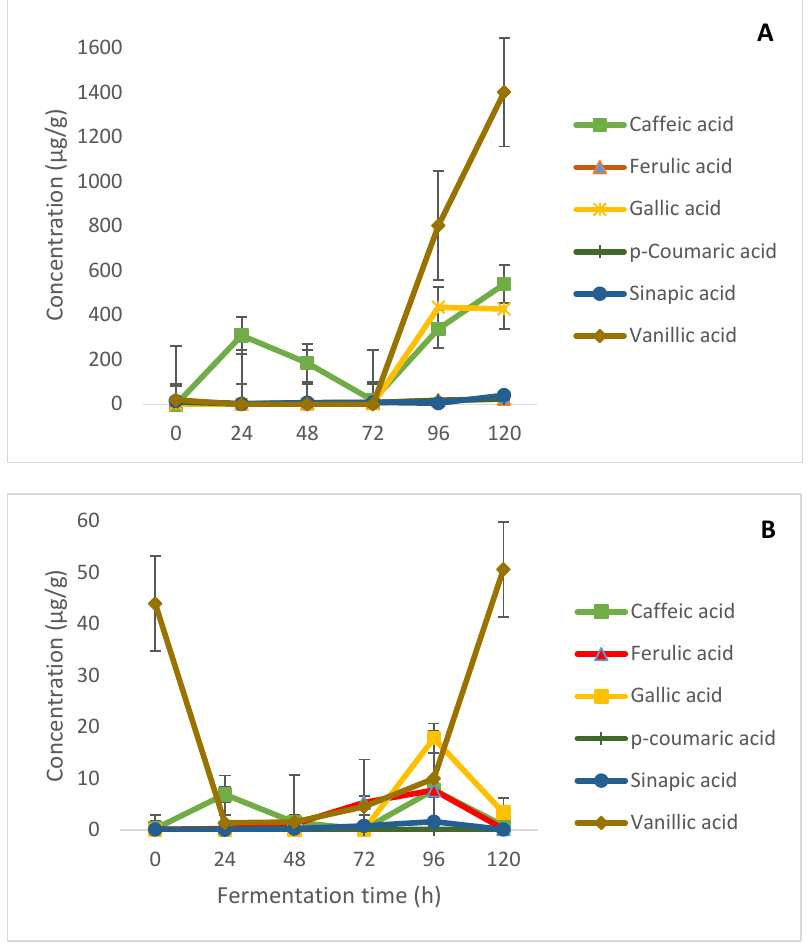
Figure 4. Modification of ( A ) free and ( B ) bound phenolic acids in fermented maize flour over time. Contrary to the kinetics of bound flavonoids, the first-order kinetic model more appropriately described the time-dependent changes in bound phenolic acids. Both first- and second-order kinetics better described the effect of fermentation on free phenolics with comparable R 2 and k values, as compared to zero-order kinetics (Table 2). However, second-order kinetics were preferable in describing the changes in free phenolic acids, with the highest reaction rate constants of the three models used. The R 2 values obtained for bound phenolic acids using first-order kinetics (0.02–0.59) were higher than those obtained when zero-order (0.004–0.28) and second-order (0.005–0.28) were used. The release of bound phenolics from fermented maize products was depicted to have proceeded at faster rates for all bound phenolic acids by zero- and second-order kinetic models, evident by the higher k values compared to first-order kinetics which produced the lowest k values. However, the higher coefficients of determination (R 2 ) produced by the first-order kinetics showed that the model better described the changes in bound phenolic acids, despite lower rates than were described by the zero- and second-order kinetics—hence the choice of first-order